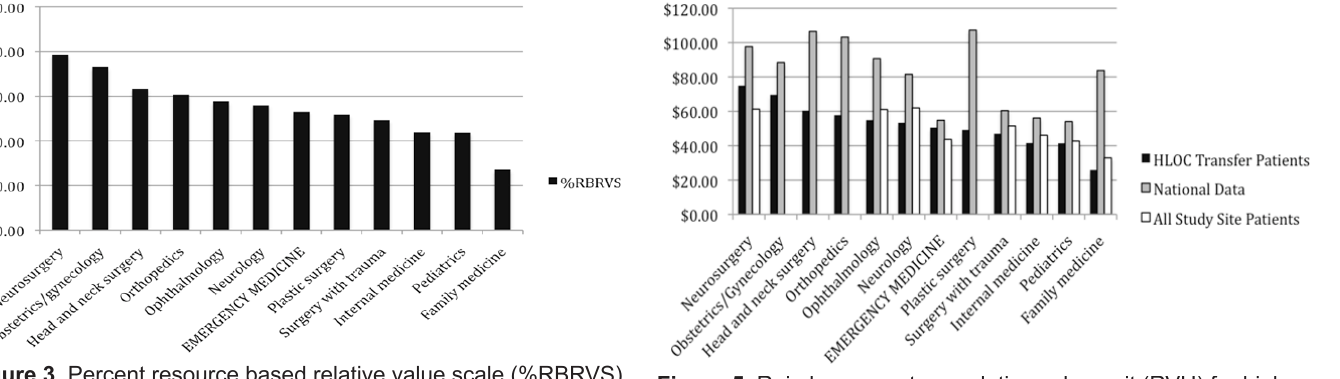
Figure 5 . Reimbursement per relative value unit (RVU) for higher level of care (HLOC) transfer patients vs. national benchmarks vs. study site patients.